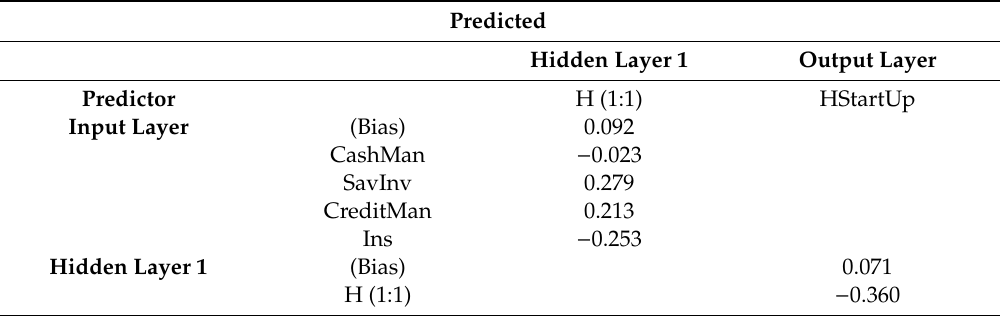
Table 6. Parameter Estimates for Model C (calculated by the authors).